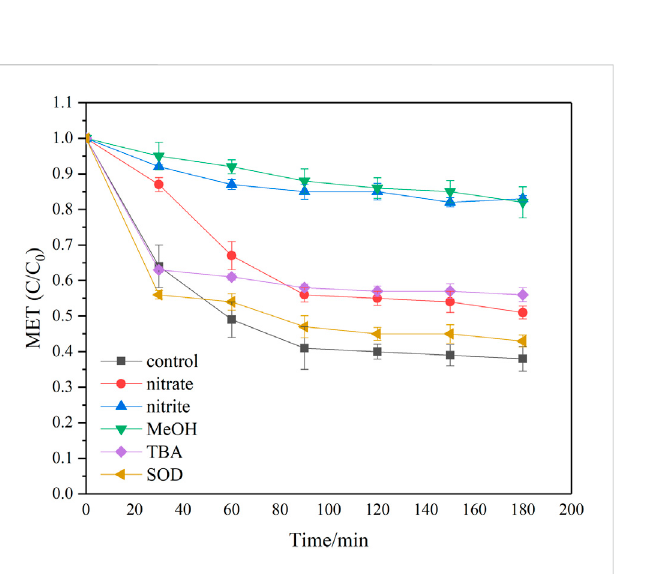
FIGURE 2 The effect of different scavengers on MET